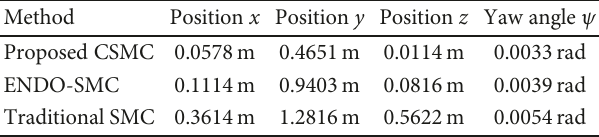
Table 1: The root mean square (RMS) of tracking errors.